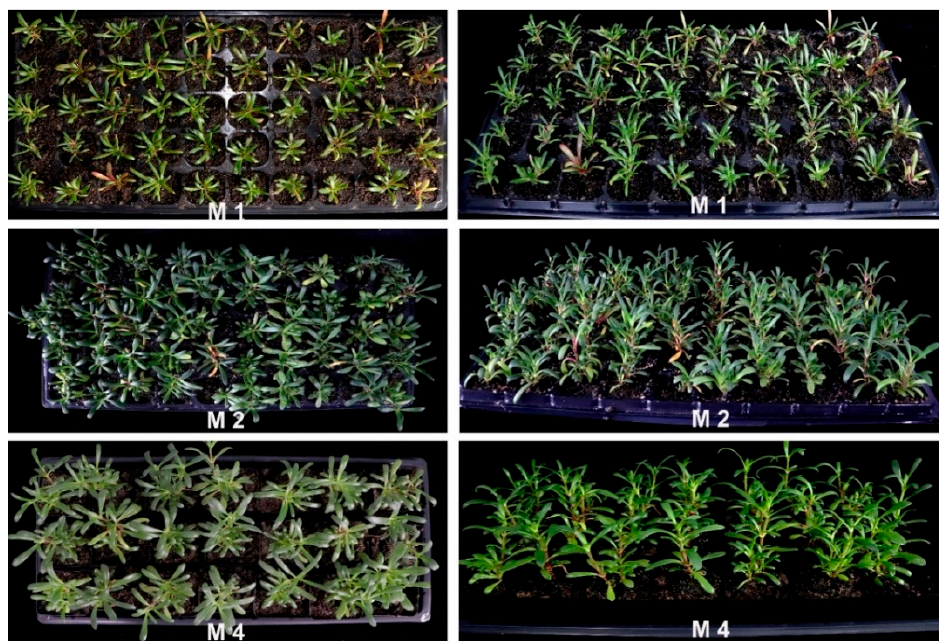
Figure 5. Acclimatization of plants in a greenhouse where in vitro rooted plants were transplanted into a cell plug tray filled with a substrate and grown in the greenhouse for one month (upper panel, M1 top view and side view, respectively). Middle panel: a top view and side view of plants after two months of growth in a plug tray. Bottom panel: a top view and side view of plants grown in 10 cm square pots at month four in the greenhouse.